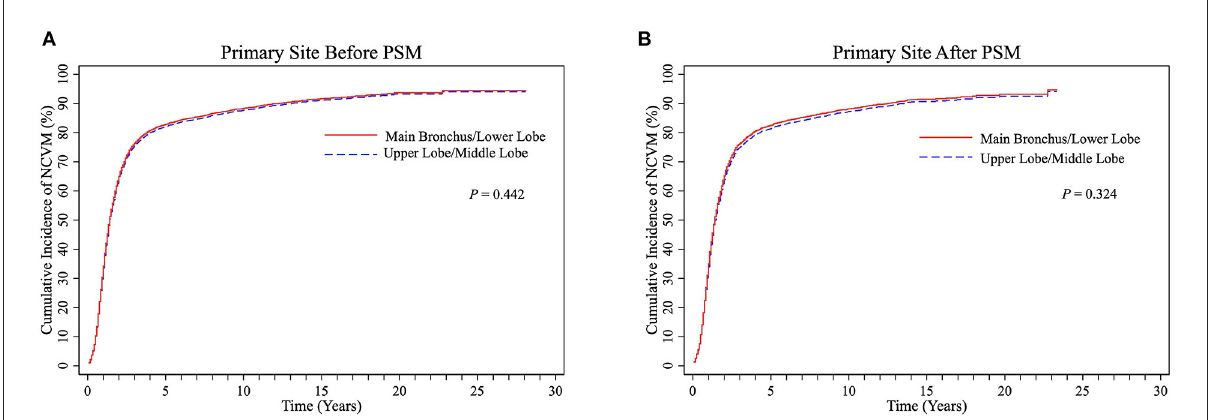
FIGURE5 CIF curves of NCVM post-radiotherapy stratified into UL/ML and MB/LL groups by primary site before (A) and after (B) PSM in LS-SCLC patients. CIF, cumulative incidence function; CVM, cardiovascular mortality; UL/ML, upper lobe/middle lobe; MB/LL, main bronchus/lower lobe; PSM, propensity score matching; LS-SCLC, limited-stage small cell lung